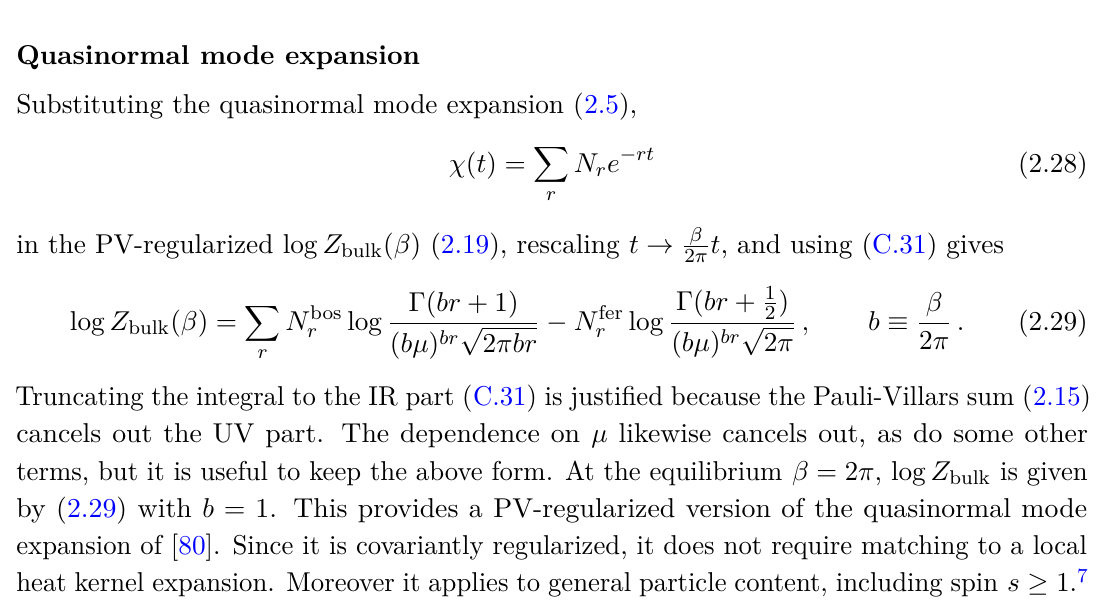
Figure 8 . Contribution to β = 2 π bulk entropy and heat capacity of a quasinormal mode ∝ e − rT , r ∈ C , Re r > 0 . Only the real part is shown here because complex r come in conjugate pairs + n ± iν . The harmonic oscillator case corresponds to the imaginary r n, ± = d 2